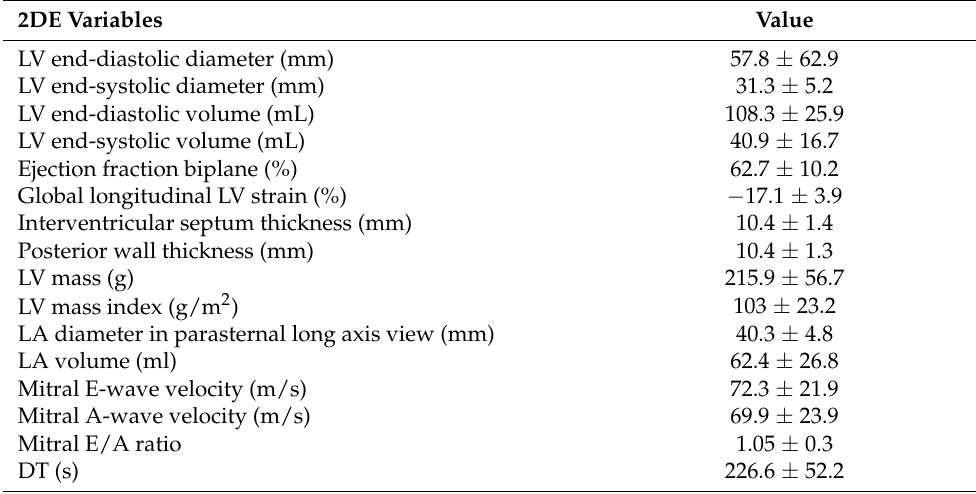
Table 2. Two-dimensional echocardiographic (2DE) parameters of the left ventricular structure and function in the study